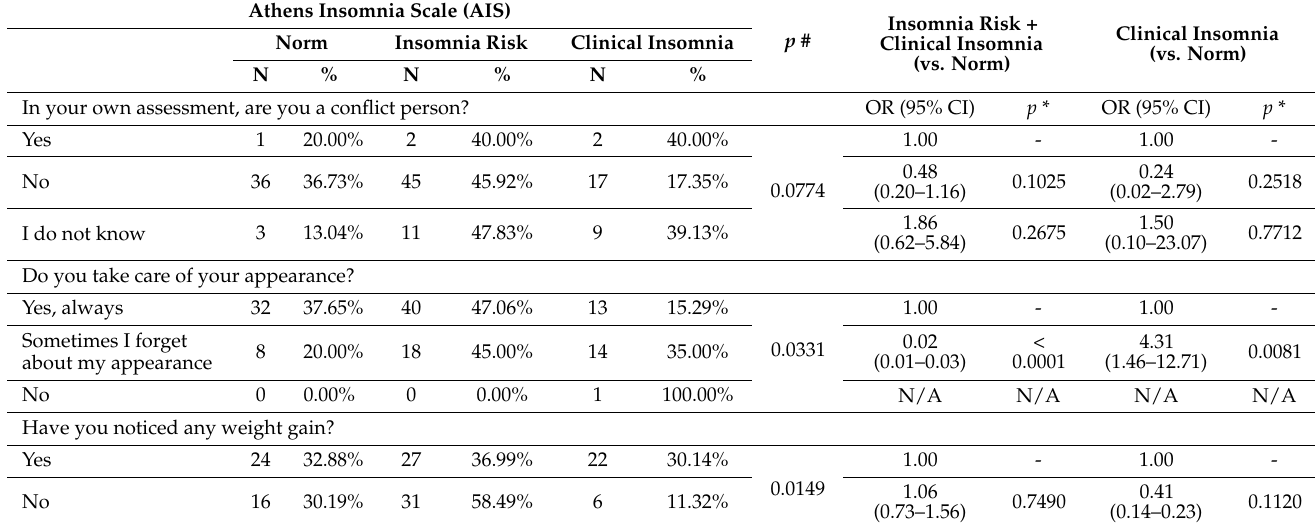
Table 10. Caring for one’s own appearance and respondents’ sleep